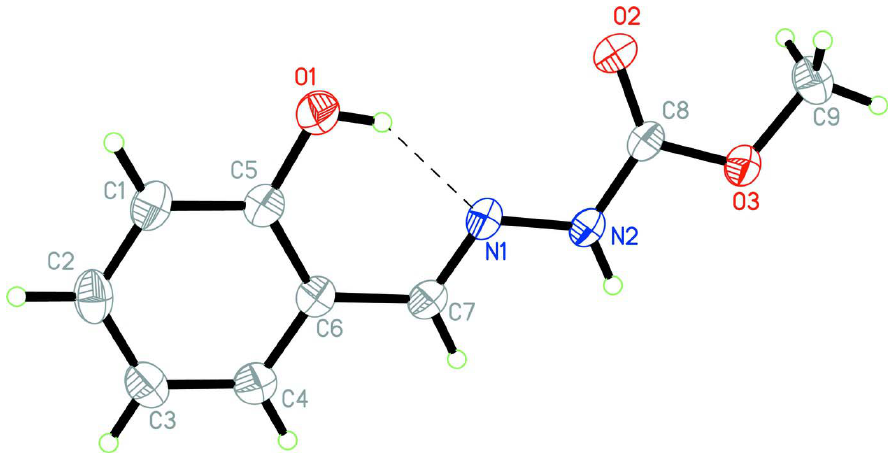
Figure 1 Molecular structure of (I), showing 30% probability displacement ellipsoids and the atomic numbering. Dashed line denotes intramolecular hydrogen